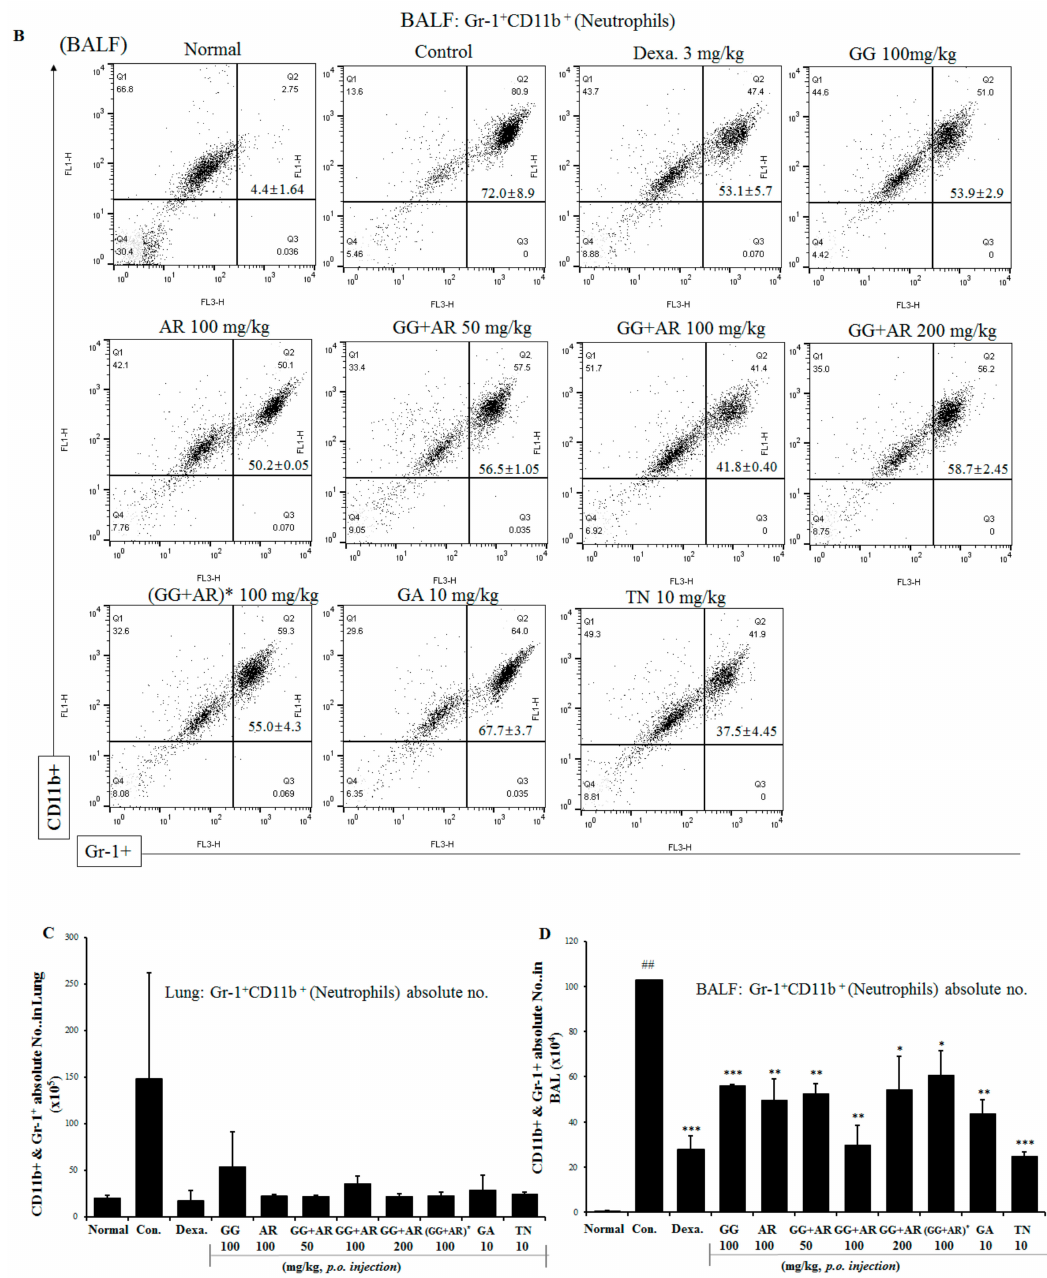
Figure 6. Inhibitory e ff ect of GG, AR, GG plus AR, GA, and TN on CD11b + Gr-1 + (high) neutrophils infiltration in lung tissue ( A ) and BALF ( B ) of COPD model mice. Samples were measured on flow cytometer and analyzed by two-color flow cytometry using a FACS Calibur device and CellQuest software (BD Biosciences, Mountain View, CA, USA). Absolute cell number of CD11b + Gr-1 + (high) (neutrophils) present in lungs ( C ), and BALF ( D ). Normal: normal group; Con.: CFD, CFD-induced COPD model group; Dexa.: CFD solution and administrated with dexamethasone 3 mg / kg group; GG 100: CFD solution and administrated with GG extract 100 mg / kg group; AR 100: CFD solution and administrated with AR extract 100 mg / kg group; GG + AR 50: CFD solution and administrated with GG plus AR extract 50 mg / kg group; GG + AR 100: CFD solution and administrated with GG plus AR extract 100 mg / kg group; GG + AR 200: CFD solution and administrated with GG plus AR extract 200 mg / kg group; GG + AR 100* (trial product): CFD solution and administrated with GG plus AR (trial product) 100 mg / kg group; GA 10: CFD solution and administrated with GA 10 mg / kg